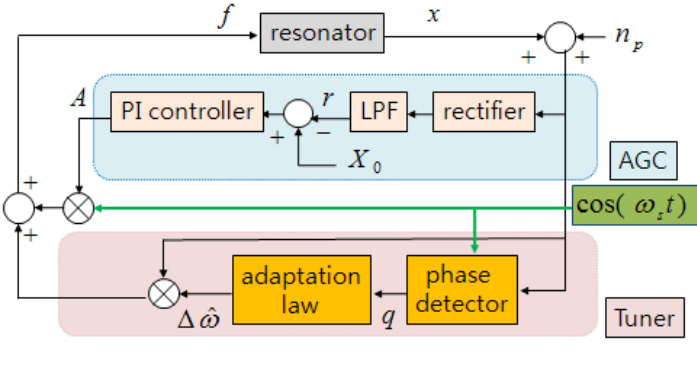
Figure 2. Block diagram of frequency tuning and amplitude